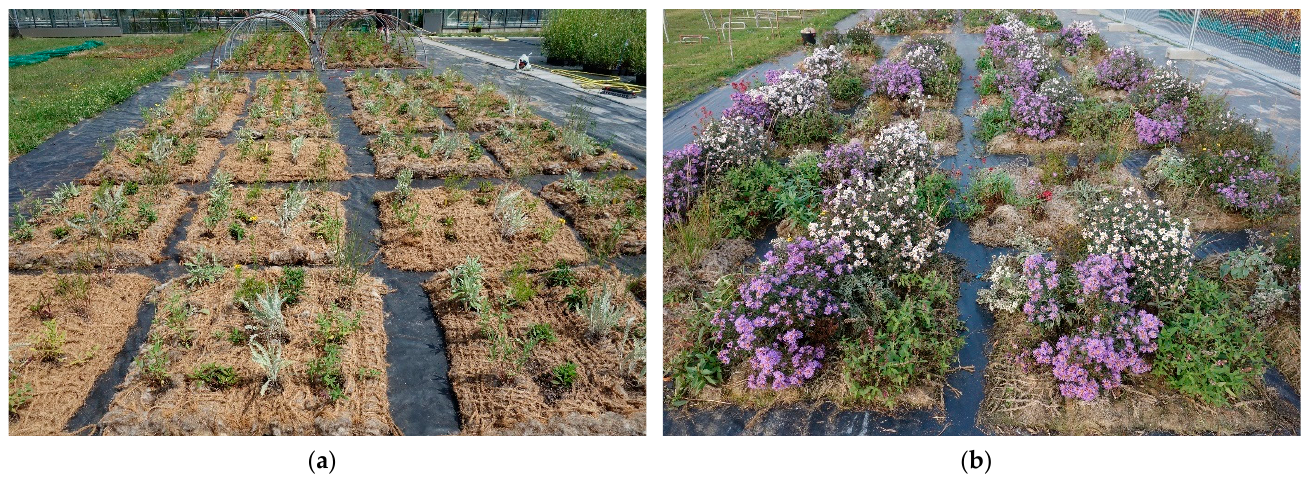
Figure 1. Experimental arrangement of perennial mats: ( a ) start of pre-cultivation (June 2015) ( b ) end of pre-cultivation (October 2015).